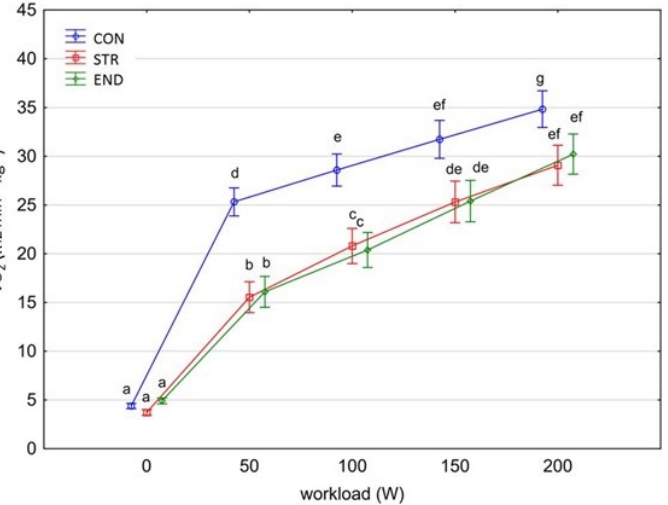
Figure 2. Oxygen uptake (VO 2 ) at rest and its response during the progressive exercise test; point and whiskers—mean ± 95% CI; the signs—a, b, c, d, e, f, g indicate homogeneous groups ( post-hoc Tukey’s HSD test: p > 0.05).